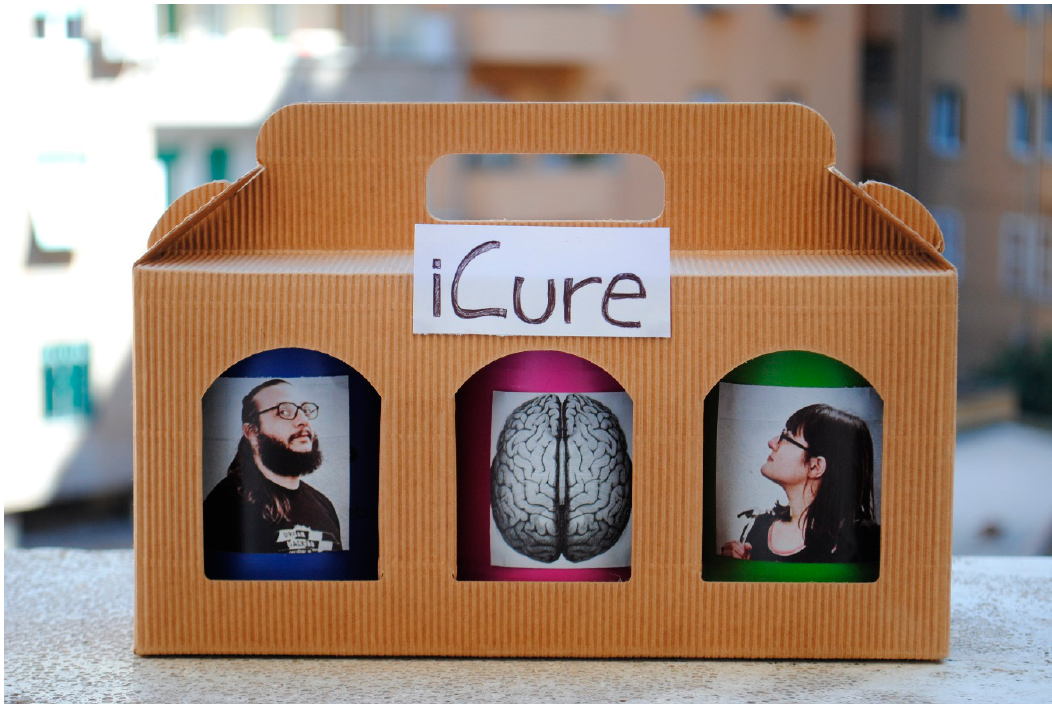
Figure 3. An example of community response to the project; screenshot from the Webpage http://la-cura.it. Courtesy of the